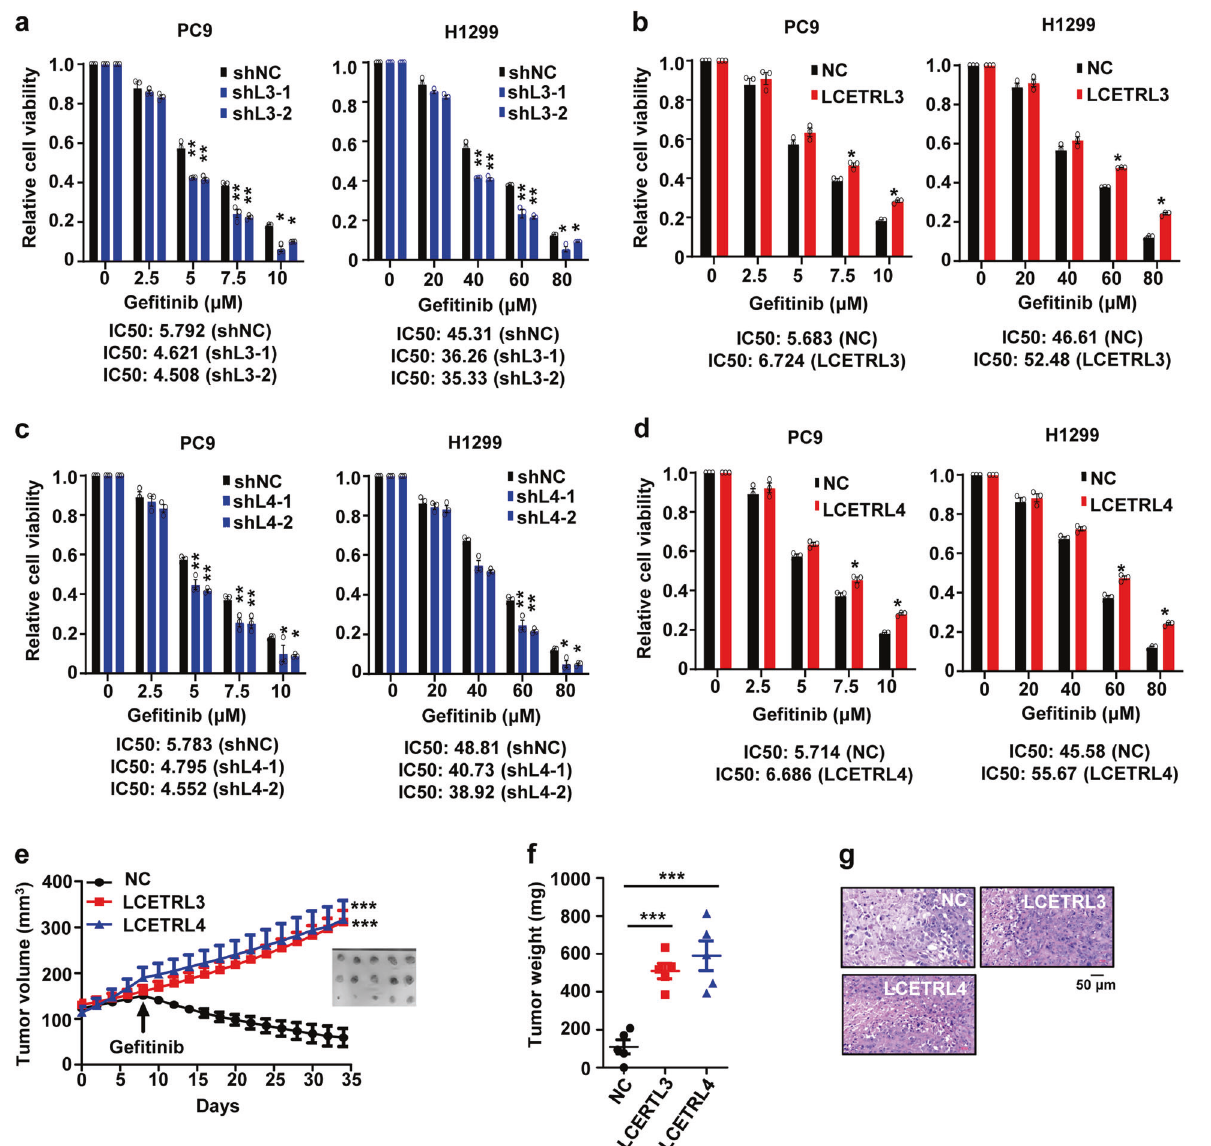
Fig. 3 LncRNAs LCETRL3 and LCETRL4 signi fi cantly diminished the antiproliferation effects of ge fi tinib in vitro and in vivo. ( a, b ) LncRNA LCETRL3 evidently decreased the antiproliferation effects of ge fi tinib in PC9 and H1299 cells. ( c, d ) LncRNA LCETRL4 also obviously